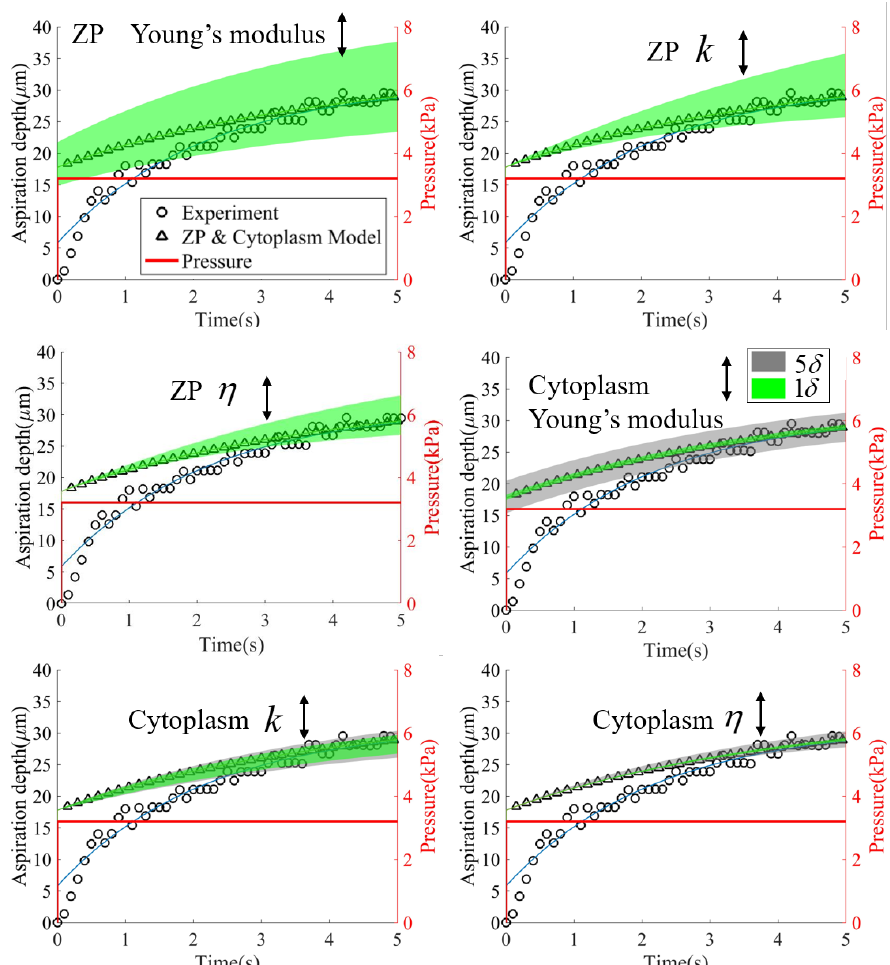
Figure 8. The aspiration length derived from the ZP and cytoplasm model varying with the Young’s modulus of the ZP, the k of the ZP, the η of the ZP, the Young’s modulus of the cytoplasm, the k of the cytoplasm and the η of the cytoplasm to various extents. These parameters were tuned by ± standard deviation δ (green area), as summarized in Table 1. The Young’s modulus of the ZP profoundly influenced both the instantaneous elastic deformation and final steady value, while the k and η of the ZP mainly affected the final steady value. Only the variation of k of the cytoplasm had an observable effect on the final steady value. So we changed the variation from ± 1 δ to ± 5 δ (gray area) and observed the same influence of the Young’s modulus of cytoplasm on the instantaneous elastic deformation as that of the Young’s modulus of